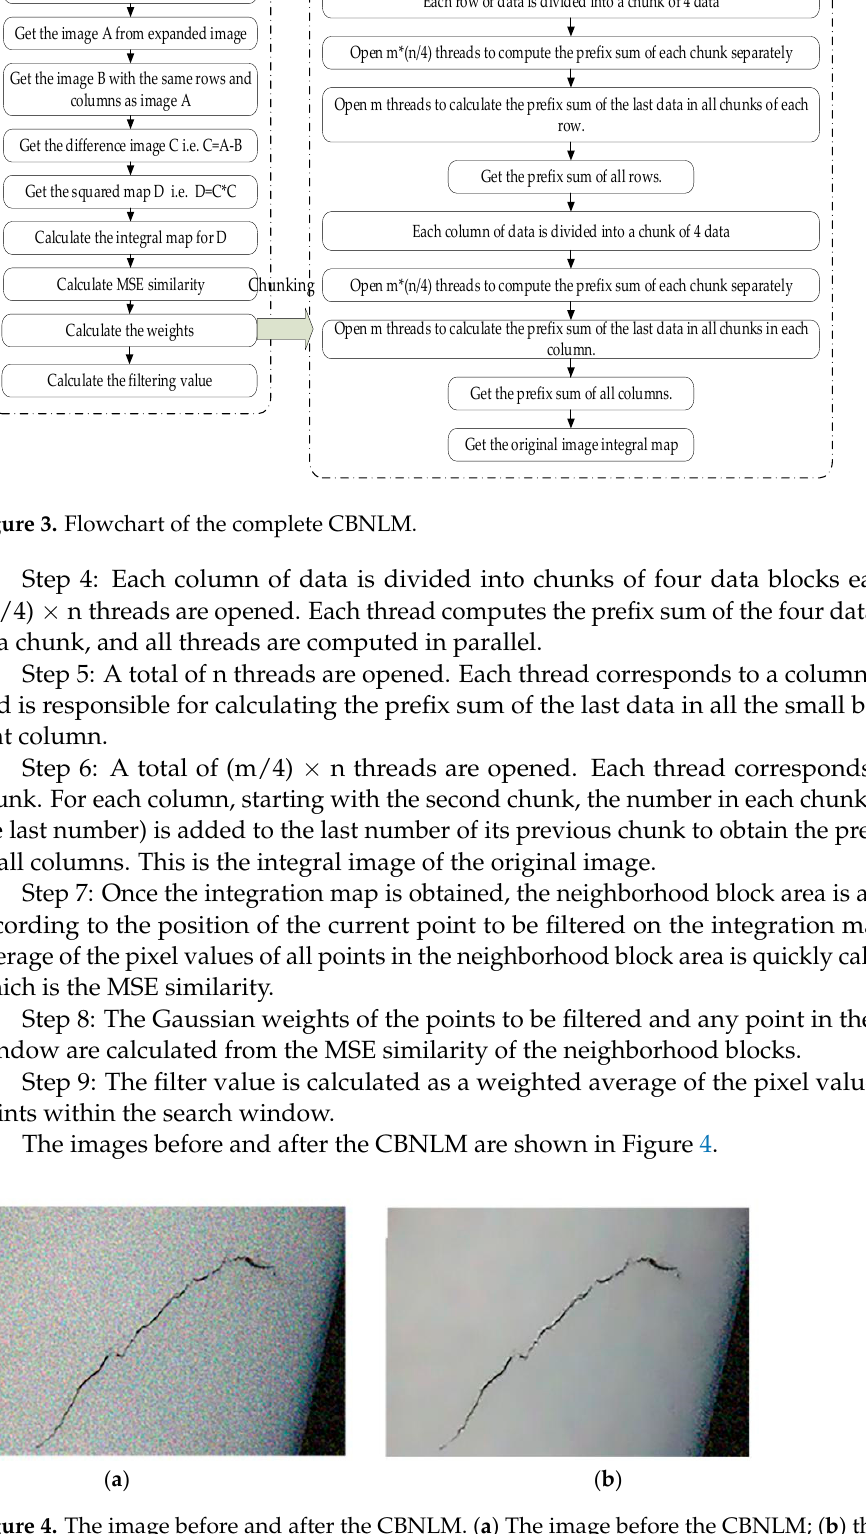
Figure 4. The image before and after the CBNLM. ( a ) The image before the CBNLM; ( b ) the image after the CBNLM.